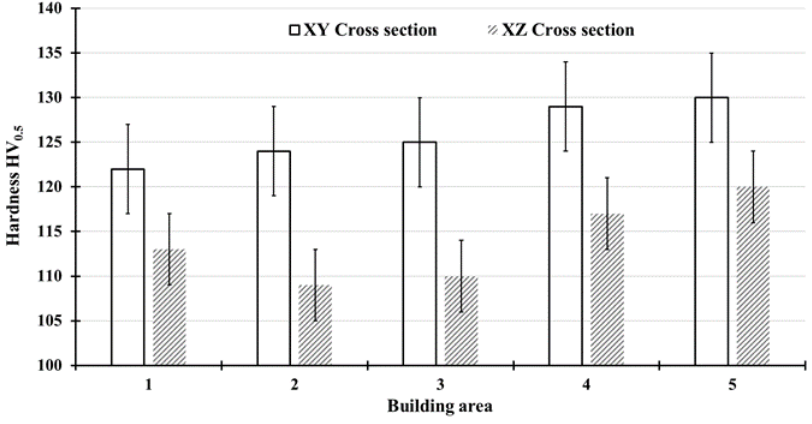
Figure 2. Average hardness in function-tested orientations according to the different production areas on the platen.